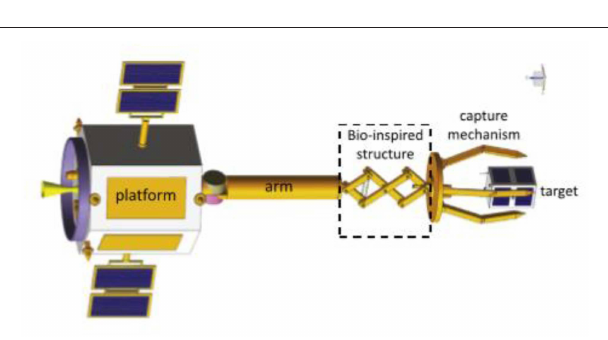
FIGURE 11 | The schematic diagram of an on-orbit capture mission (Dai et al., 2018).